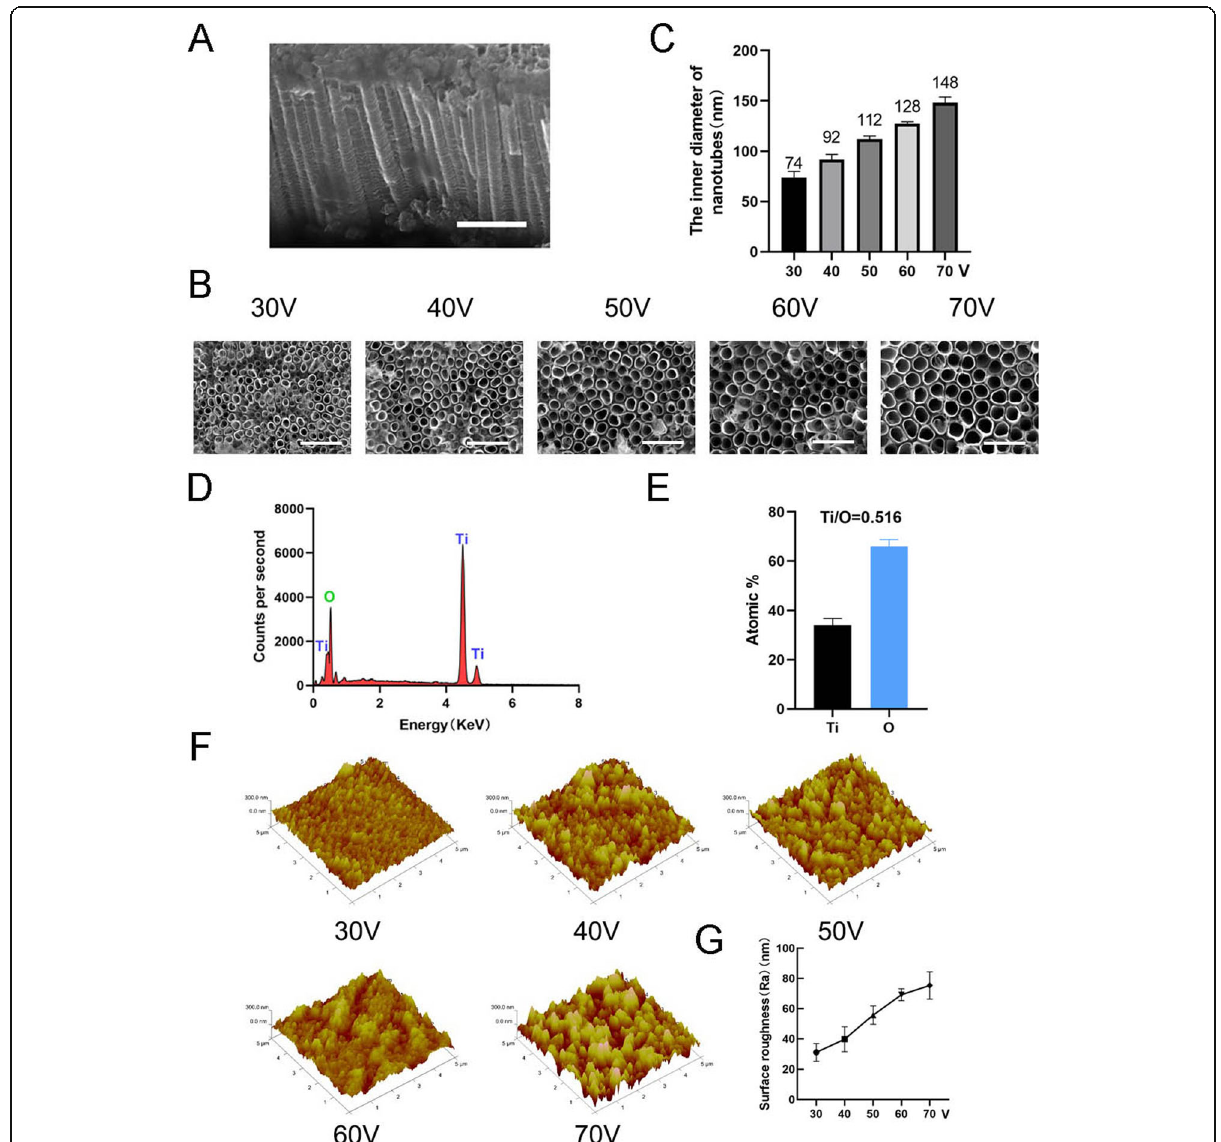
Fig. 2 Surface characterization of nanotubes. a Side view of nanotubes. Scale bars: 1 μ m. b Top view of nanotubes. Scale bars: 500 nm. c The inner diameter of the nanotubes at five different constant voltages (30, 40, 50, 60, 70 V). d The EDS chemical element composition of nanotube structures. e The element ratio of Ti and O. f Atomic force microscopy (AFM) images of nanotube structures. g The average surface roughness (Ra) of the